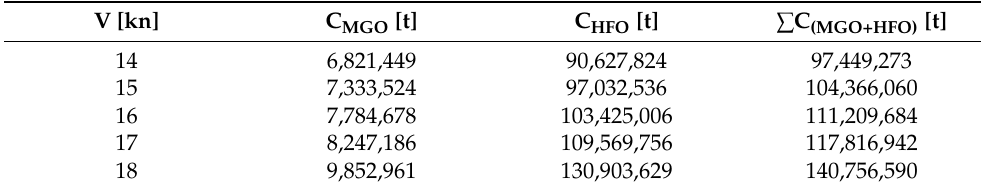
Table 4. Calculated fuel consumption figures for container ships in 2018. V [kn] C MGO [t] C HFO [t] ∑ C (MGO+HFO) [t]